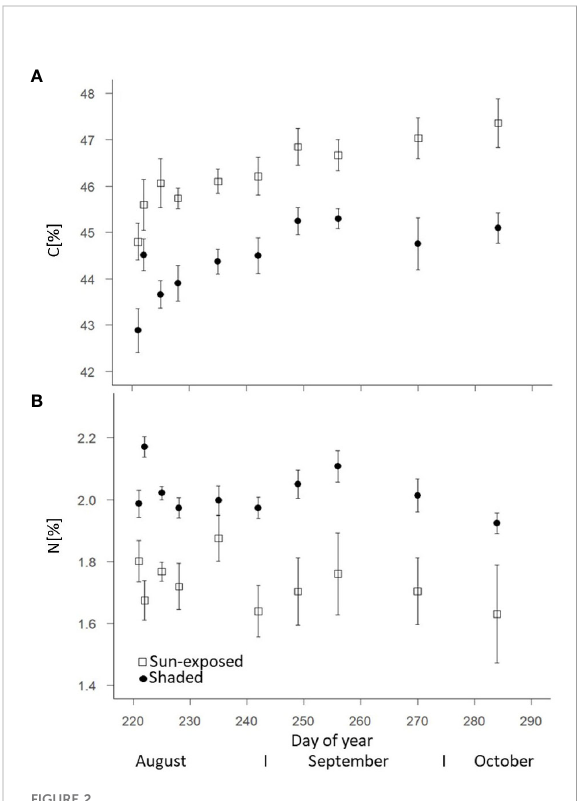
FIGURE 2 Change of the carbon (A) and nitrogen (B) concentrations of sun-exposed and shaded leaves during the late growing season ( fi eld replicates n=8 with 2 analytical replicates, each, error bars indicate